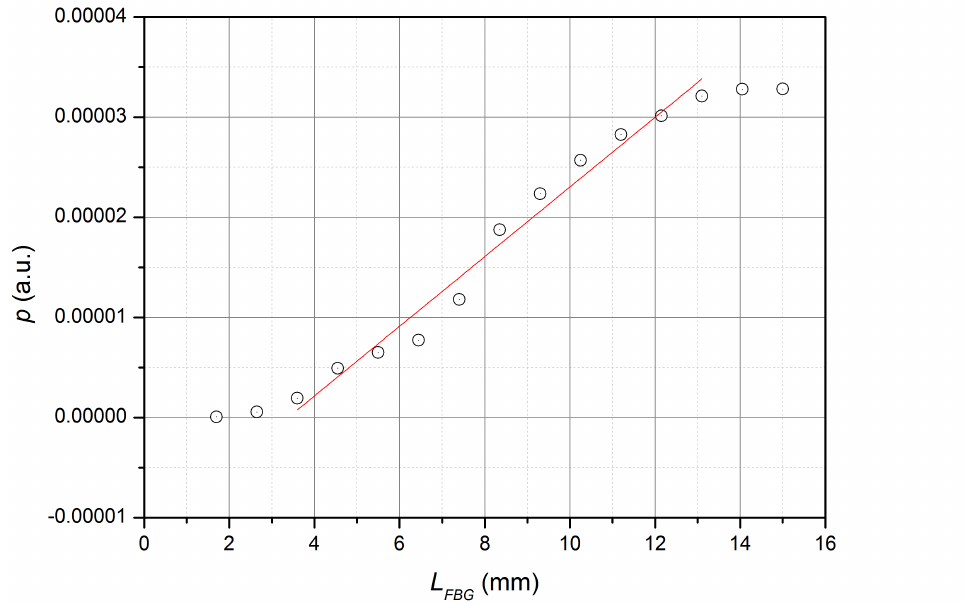
Figure 5. Dependence of the maximum spectral density of reflected radiation on the FBG length (experiment and linear approximation in the length range of 3–13